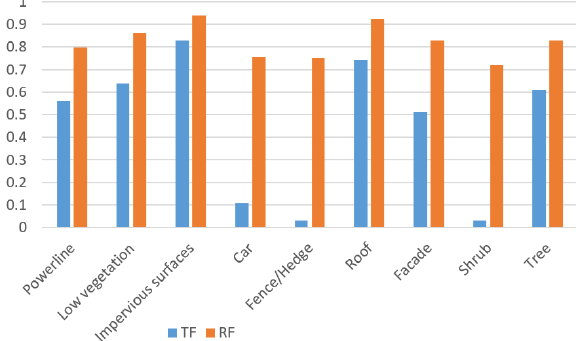
Figure 4. Comparison of best F1 values between classes and methods used.